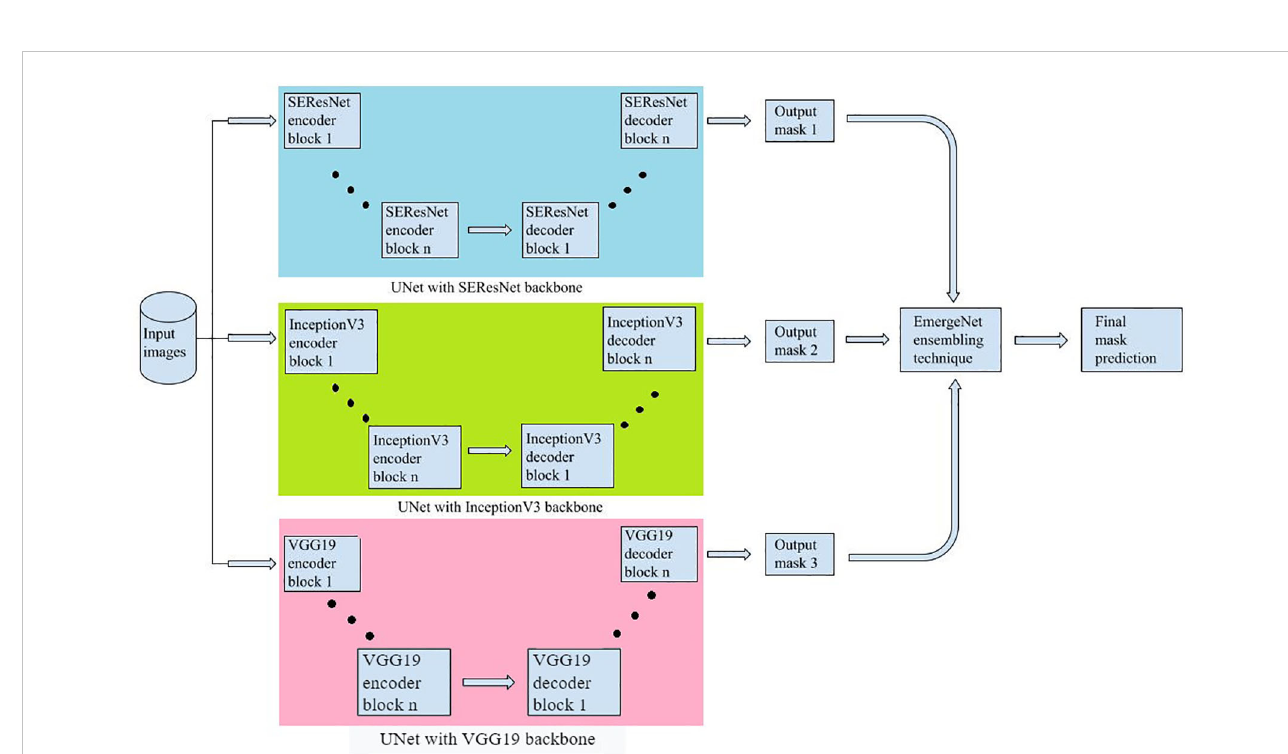
FIGURE 5 The proposed EmergeNet